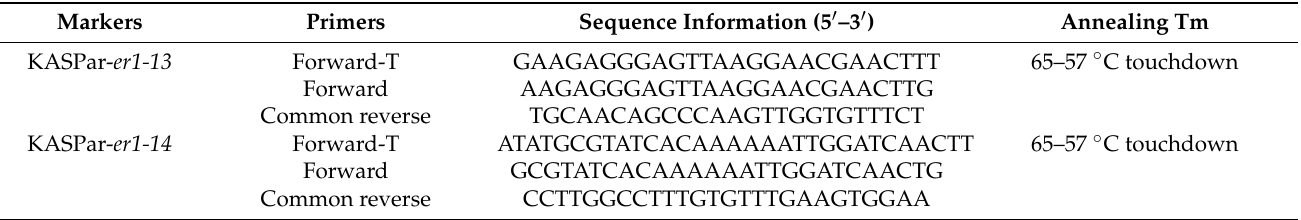
Table 2. Sequence information for the indel and Kompetitive allele-specific PCR (KASPar) markers specific to er1 -13 and for the KASPar marker specific to er1